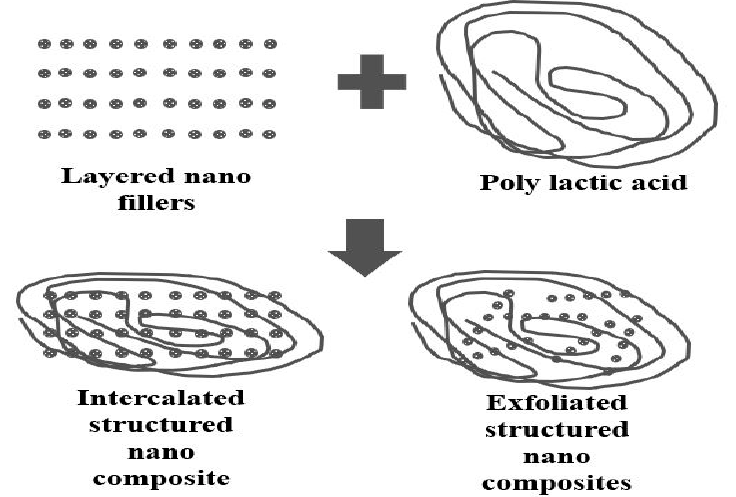
Figure 8. Intercalated and exfoliated structures.